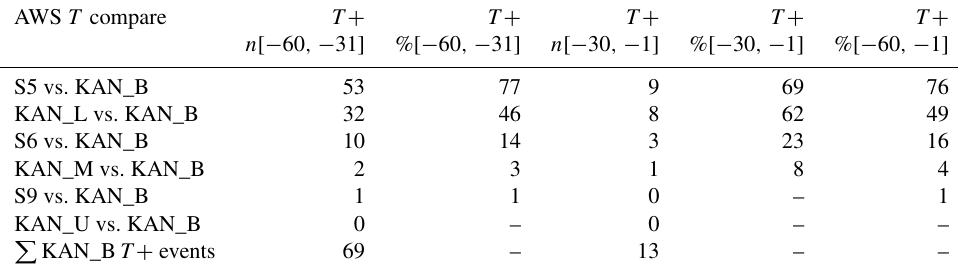
Table 2. Counts of above-freezing daily mean air temperature ( T + ) events ( n ), 2011–2015, and the percentage of contemporaneous overlap (%) between T + events at KAN_B and S5, KAN_L, S6, KAN_ M, S9, or KAN_U. The [− 60 , − 31 ] and [− 30 , − 1 ] periods reference time windows before respective annual dates of Baffin Bay sea ice advance (DOA). As an example, 77% of the time in the 30 to 60d (i.e., [− 60 , − 31 ] ) window preceding Baffin DOA the T + air temperature threshold at KAN_B is also observed at S5. AWS T compare T + T